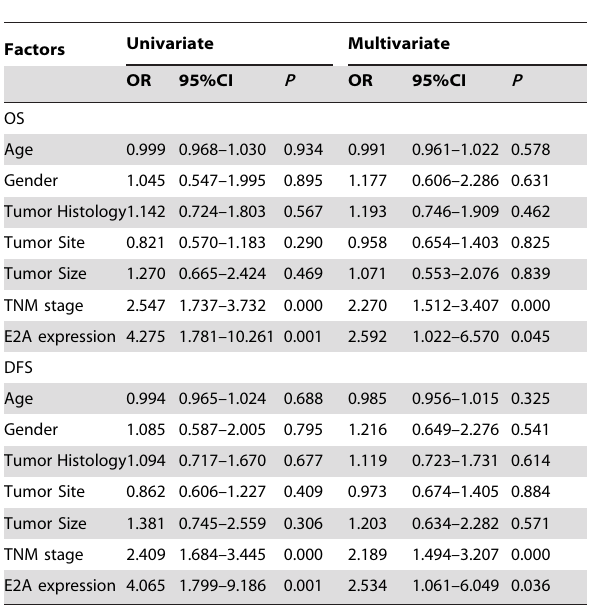
Table 3. Univariate and multivariate Cox regression analysis for OS and DFS in CRC